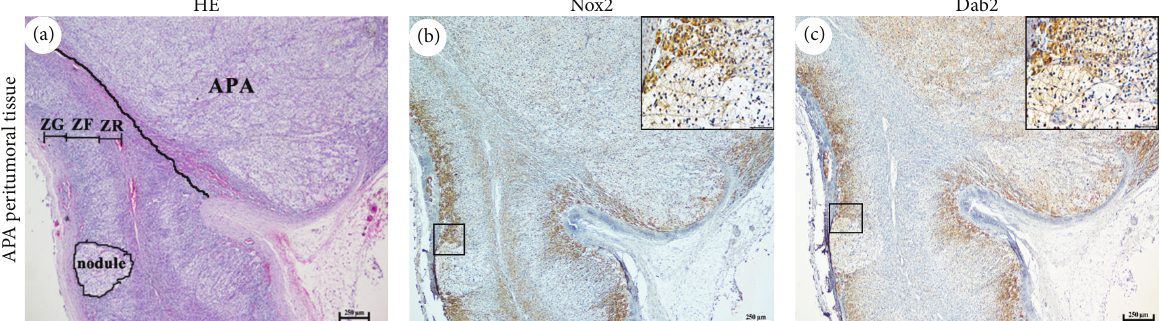
Figure 4: Morphological features and Nox2 expression in APA adjacent tissue. Adrenal hyperplasia is defined as a continuous distribution of adrenal ZG or extended focal thickness greater than 200 𝜇 m. (a) In the APA adjacent tissue, ZG hyperplasia was demonstrated by HES. Adrenocortical nodule was surrounded by hyperplastic ZG cells and composed of ZF-like cells in APA. (b) Nox2 was expressed in the entire hyperplasic ZG and ZR cells, but not adrenocortical nodule. (c) Dab2 was expressed in the entire hyperplasic ZG cells. Bar, 250 𝜇 m on low magnification (40x) and 50 𝜇 m on high magnification